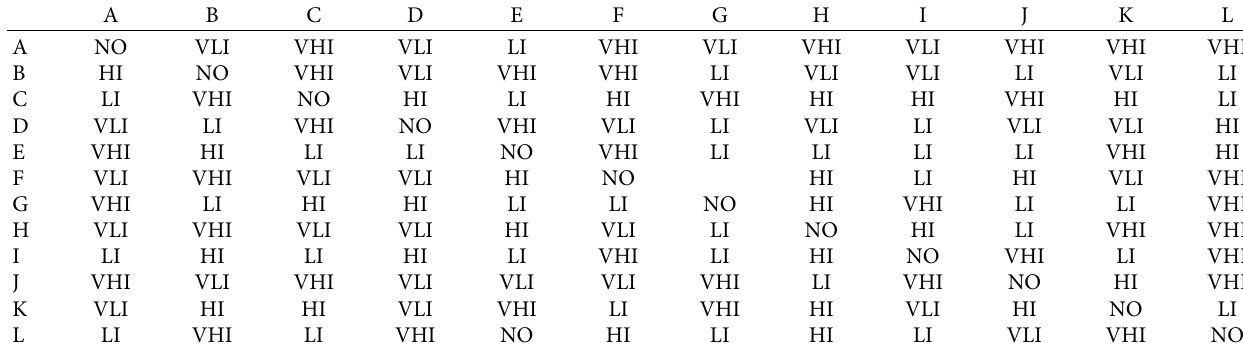
Table 7: Fuzzy verbal scales for the opinions of